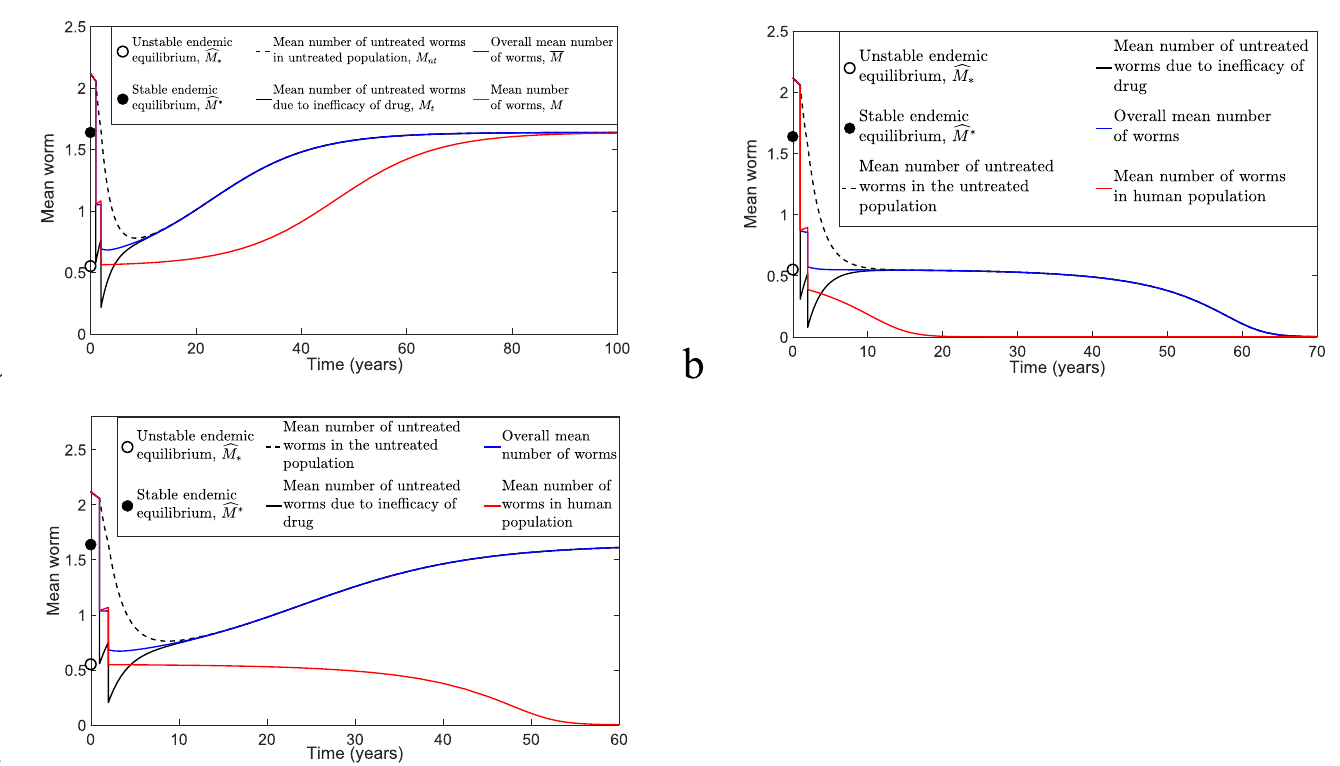
Fig 11. The numerical results of model (3) and (4) and model (9) and (10) by varying � and applying the coverage of MDA data from the TUMIKIA community- based annual deworming control strategy. (a) Disease persistence if � < 0.73. (b) Disease extinction if � � 0.85. (c) Disease elimination is possible for model (3) and (4) if � � 0.73, but the disease will remain in endemic state for model (9) and (10) if � < 0.85.